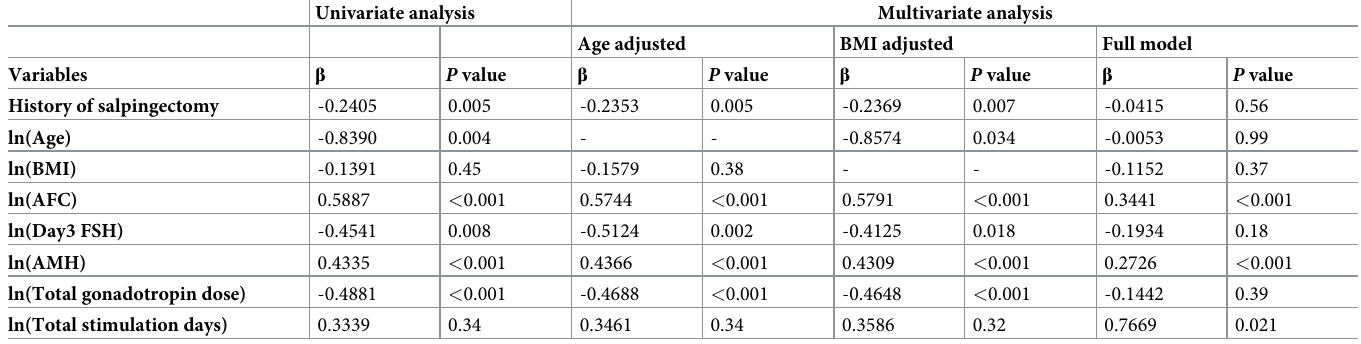
Table 2. Results of univariate and multivariate analysis of the association between the number of retrieved oocytes and history of salpingectomy, as well as other variables involved in predicting the ovarian response in IVF. Univariate analysis Multivariate analysis